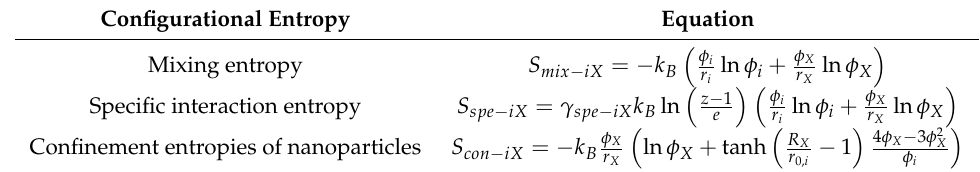
Table 1. Configurational entropies used in the theoretical modelling, where k B is the Boltzmann constant, φ i is the volume fraction of polymer i (with i = 1,2), φ X is the volume fraction of nanoparticles, r i is the molar volume of polymer i , r X is the molar volume of nanoparticles, R X is the nanoparticle radius, r 0, i is the average monomer radius of the polymer i , z is the lattice coordination number and γ spe − iX is a parameter representing the specific interaction between the polymer i and nanoparticle.